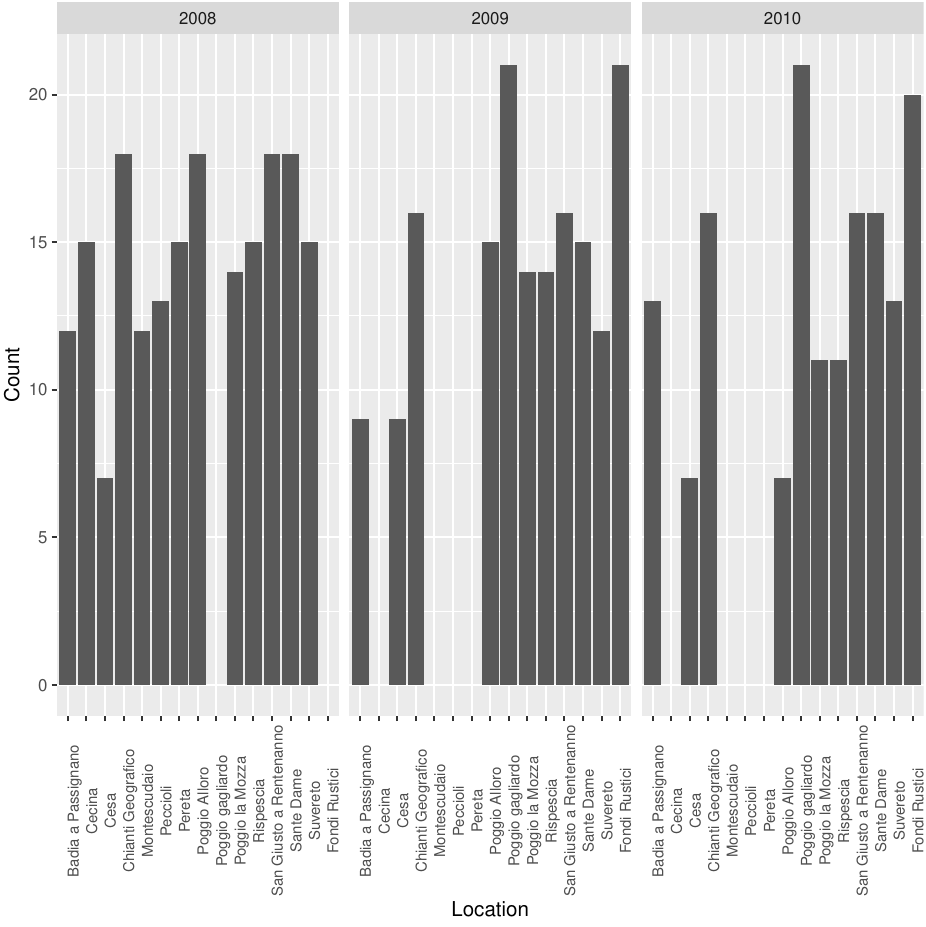
Figure 1. Dataset size by location and